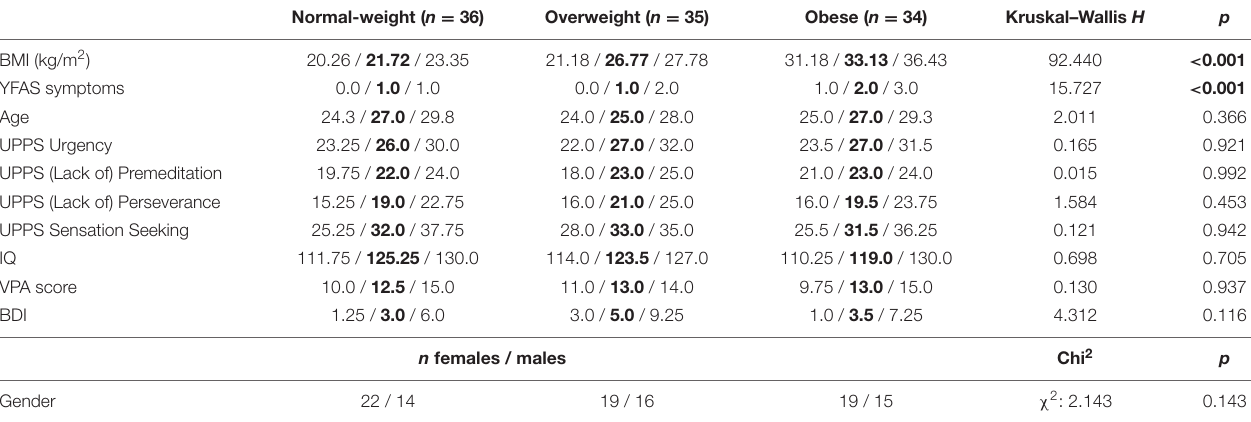
TABLE 1 | Descriptive statistics of the sample by weight status.